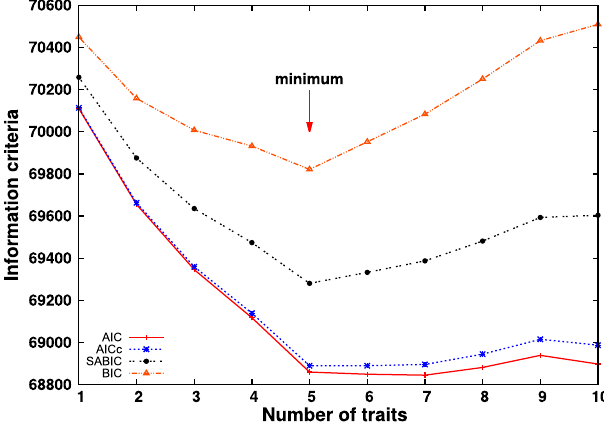
FIG. 2 (color online). Different information criteria are plotted for item response models with varying number of traits. Although Akaike ’ s Information Criterion and its corrected version (AICc) show a broad minimum plateau for 5 ≤ n ≤ 7 the other two information criteria have a definite minimum at n ¼ 5 .